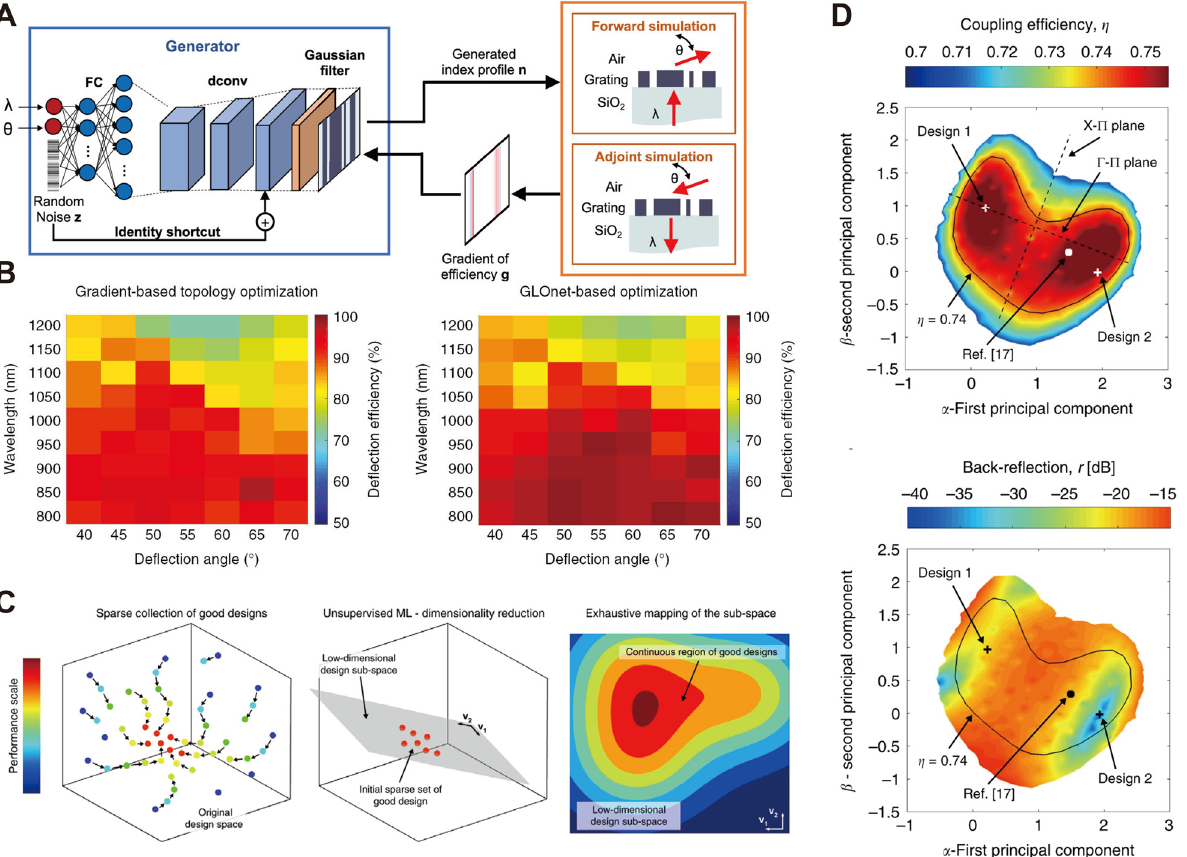
Figure 7: Hybrid design methods with deep learning models performing complex projection on design space (A) schematic of global optimization network (GLOnet) as a combination of GAN architecture and topology optimization approaches. The generated design candidates are utilized to calculate the gradient for the FOM by adjoint methods. Adapted from [15]. (B) Deflection efficiency of devices optimized by gradient topology optimization and the proposed GLOnet-based approach. The working wavelength varies from 800 nm to 1200 nm and the deflection angle varies from 40 ◦ to 70 ◦ . Adapted from [124]. (C) The PCA-based dimensionality reduction of design space for vertical grating couplers. Exhaustive mapping is conducted at the reduced sub-space to generate the optimized design. (D) Top: coupling efficiency of the optimized devices measured from the principle hyperplane. Bottom: back-reflection measured from the principle hyperplane. (C) and (D) are adapted from